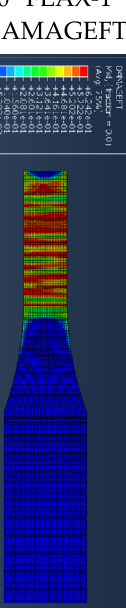
Figure 12. Damage evolution of each composite layer of the laminate B at 2 mm displacement.